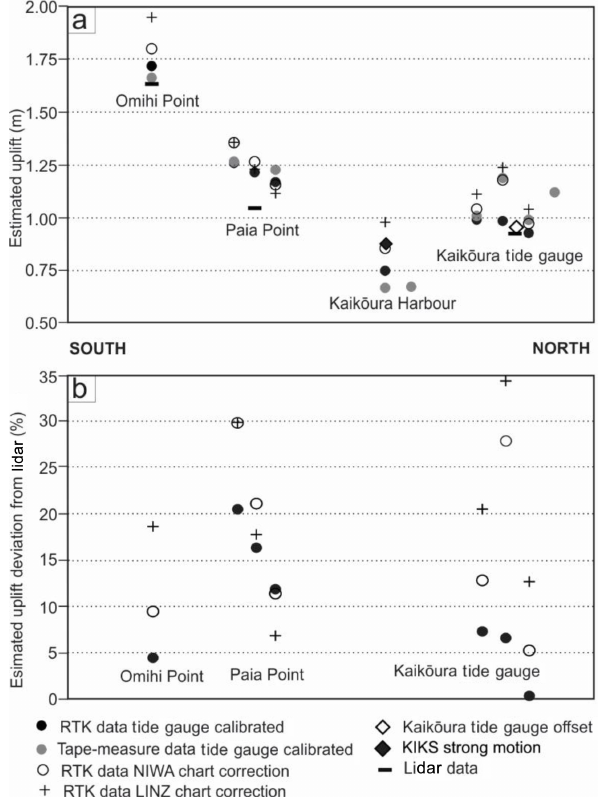
Figure 6. (a) Tectonic uplift in metres measured at the Kaik¯oura tide gauge, Kaik¯oura Harbour, Paia Point and Omihi Point from biological data processed using the tide-gauge correction, as well as NIWA and LINZ predictive tide-chart correction methods (see Sect. 3.2). These values are compared to uplift recorded by the tide gauge and differential lidar (where available). (b) Percentage of up- lift deviation of the biological methods with respect to the lidar mea- surements. Horizontal axis not to scale.